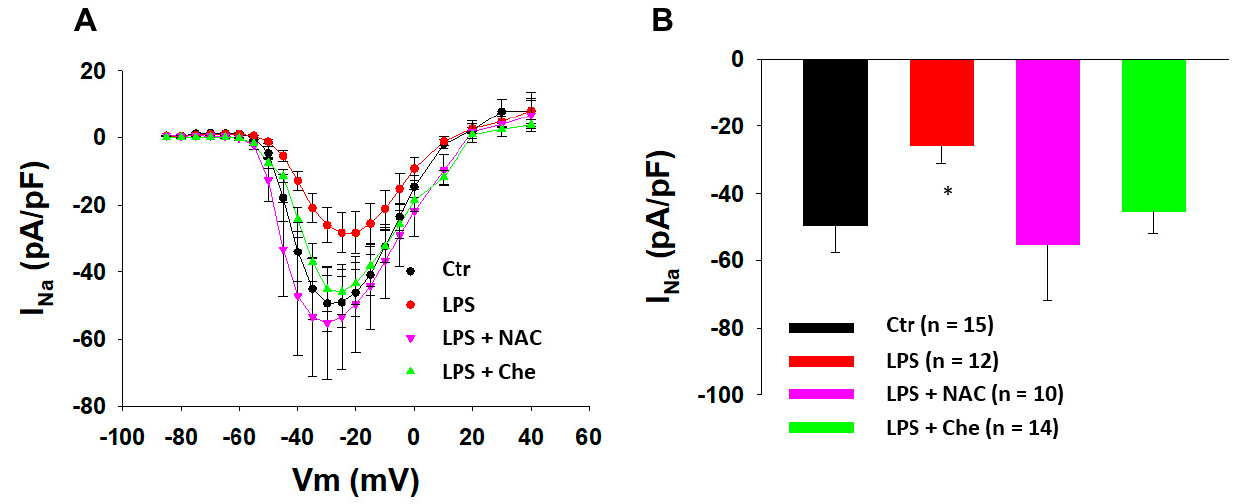
Figure 5. A ROS and PKC blocker prevented the LPS effects on sodium channel currents in SCN10A-hiPSC-CMs. Cells were treated for 48 h with vehicle (Ctr) or LPS of 2 μ g/mL (LPS) or LPS plus 1 mM N -acetylcysteine (LPS + NAC) or LPS plus 5 μ M chelerythrine (LPS + Che). ( A ) I–V curves of peak sodium channel currents (I Na ) recorded in SCN10A-hiPSC-CMs. ( B ) Mean value of peak I Na at − 30 mV. Numbers given in ( B ) represent the number of cells of measurements also for ( A ). * p < 0.05 versus Ctr according to one-way ANOVA with Holm–Sidak post-test.